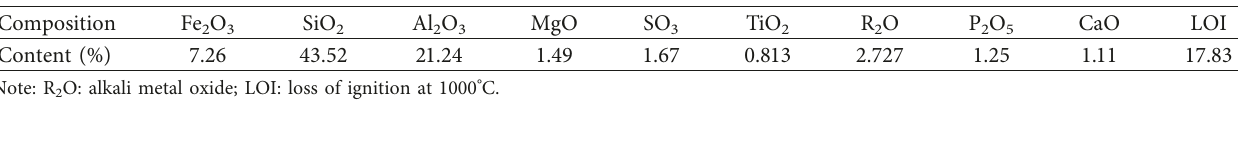
Table 3: Chemical compositions of the solidification materials.